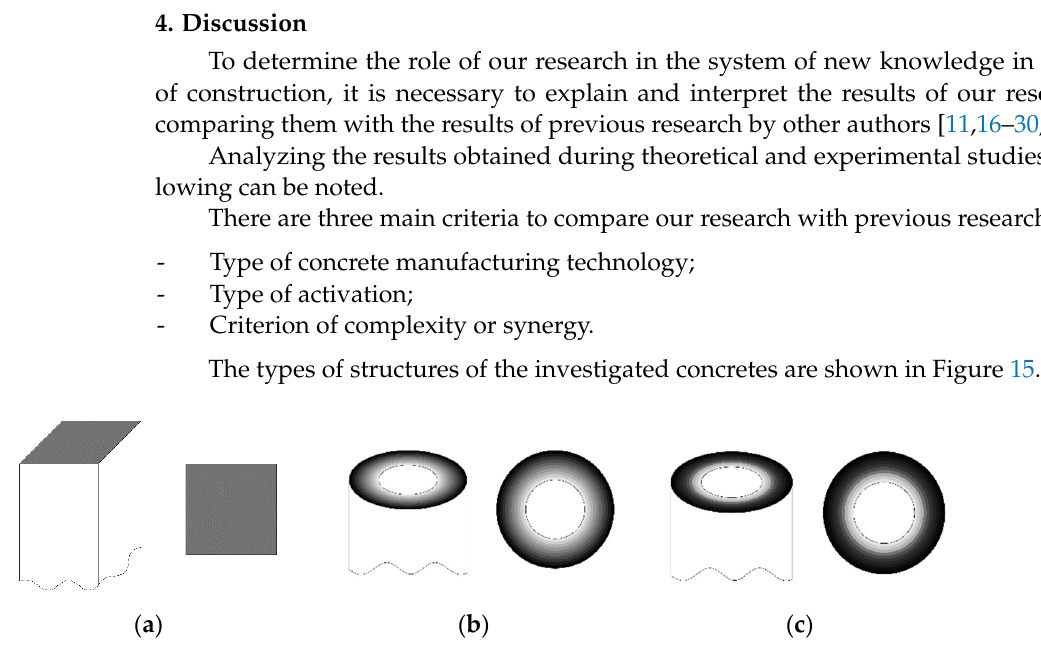
Figure 15. Types of structures of the investigated concretes: ( a ) simple structure of vibrated concrete; ( b ) variatropic structure of centrifuged concrete; ( c ) variatropic structure of vibro-centrifuged concrete.